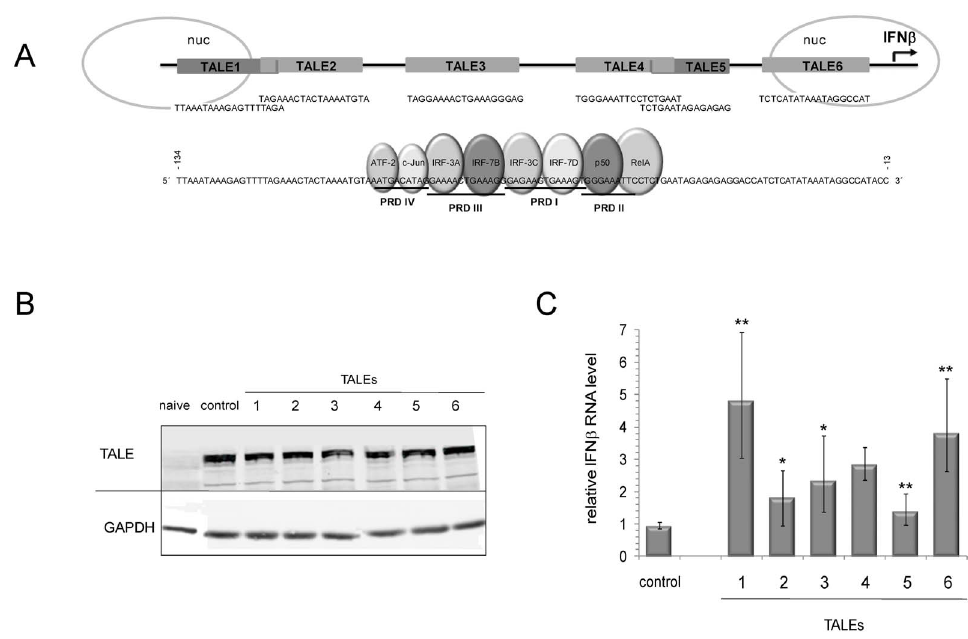
Figure 1. TALE-induced expression of IFN-beta. (A) Organization of the IFN-beta promoter (region at 2 134 to 2 13 nt upstream of transcriptional start). The nucleosome (nuc) and TALE binding sites are schematized as well as the interaction sites of transcription factors that associate with the IFN-beta promoter in activated cells forming the enhanceosome. (B) Expression levels of TALEs1–6 and of a control TALE (without human target sequence) in Huh7 cells, detected by western blot in comparison with the housekeeping protein Glyceraldehyde-3- Phosphate Dehydrogenase (GAPDH). (C) IFN-beta mRNA level in Huh7 cells at 24 h post-transfection (p.t.) of TALE-expressing plasmids (IFN-beta mRNA level in control set as 1). Error bars indicate standard deviations of seven independent experiments. (* 5 P , 0,05, ** 5 P ,